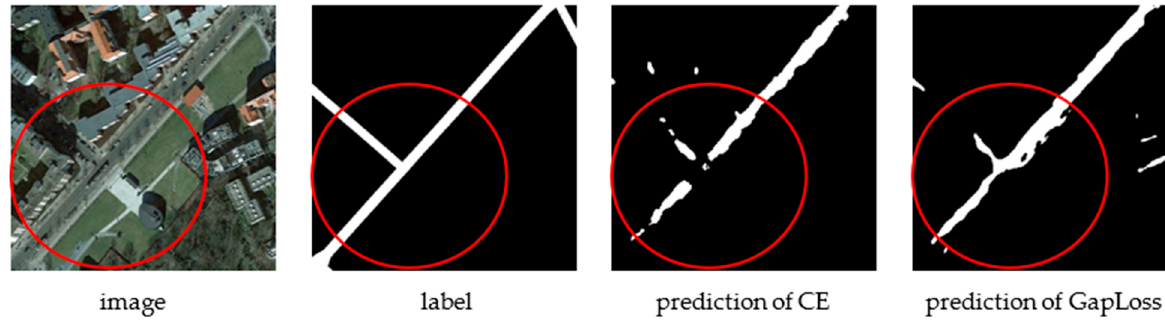
Figure 13. MUNet results with CE and GapLoss on Aerial Image Segmentation Dataset.